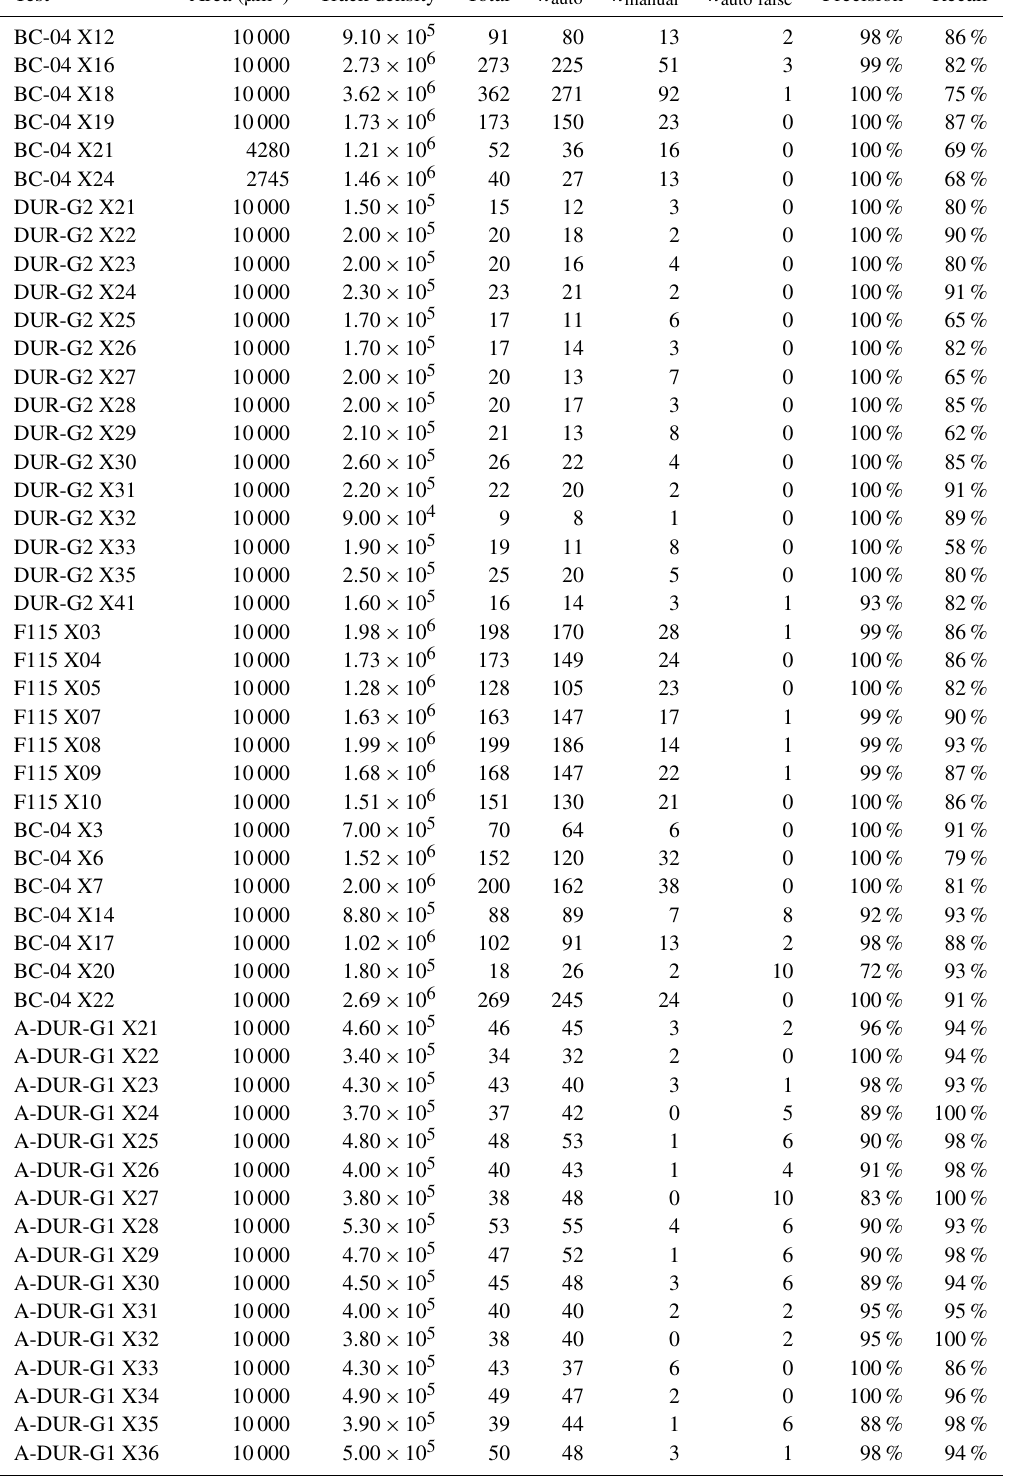
Table 1. Test results of the automatic fission track recognition in apatite (confidence threshold = 0.1). Areal track density is expressed in tracks per square centimetre (trackscm − 2 ). The number of correctly automatically detected tracks (true positives), manually detected tracks (false negatives), and erroneously detected tracks (false positives) are indicated by n auto , n manual , and n auto false